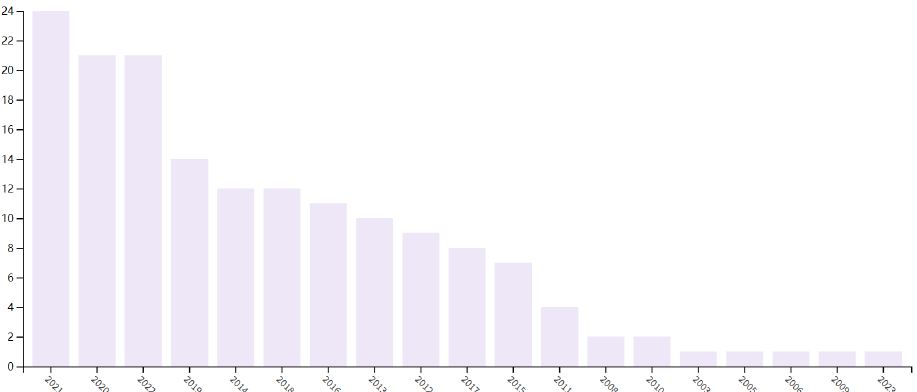
Figure 1. The bibliometric analysis of cross-linked polybenzimidazole for high-temperature proton exchange membrane fuel